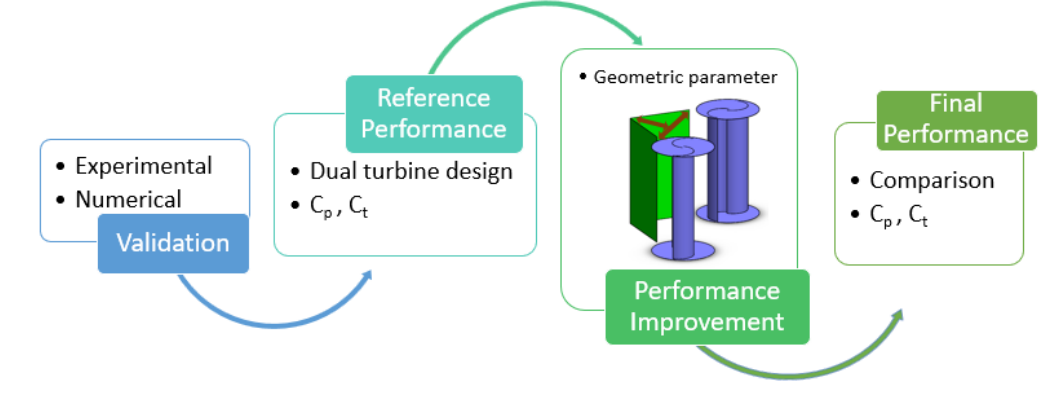
Figure 1. Study Methodology.